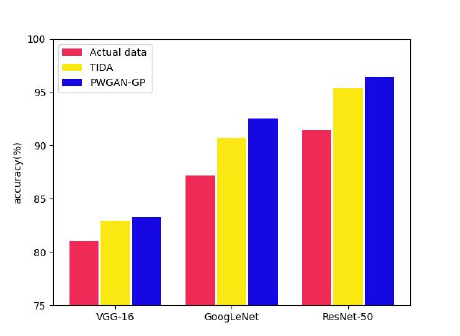
Figure 15. Impact of data enhancement on the accuracy of neural networks.